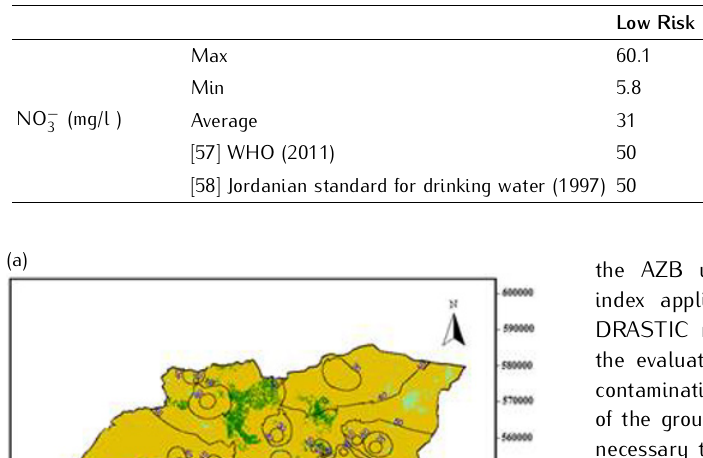
3 concentrations of the risk map of the study area.